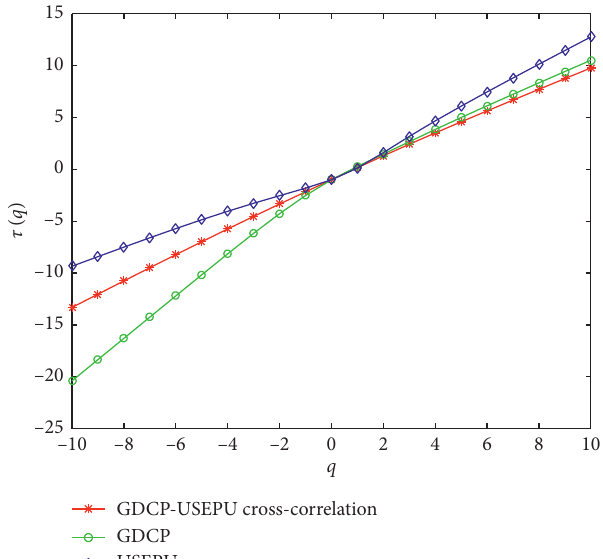
Figure 6: R´enyi exponent of τ ( q ) versus q for GDCP and USEPU cross-correlation, the correlation of GDCP, and the correlation of